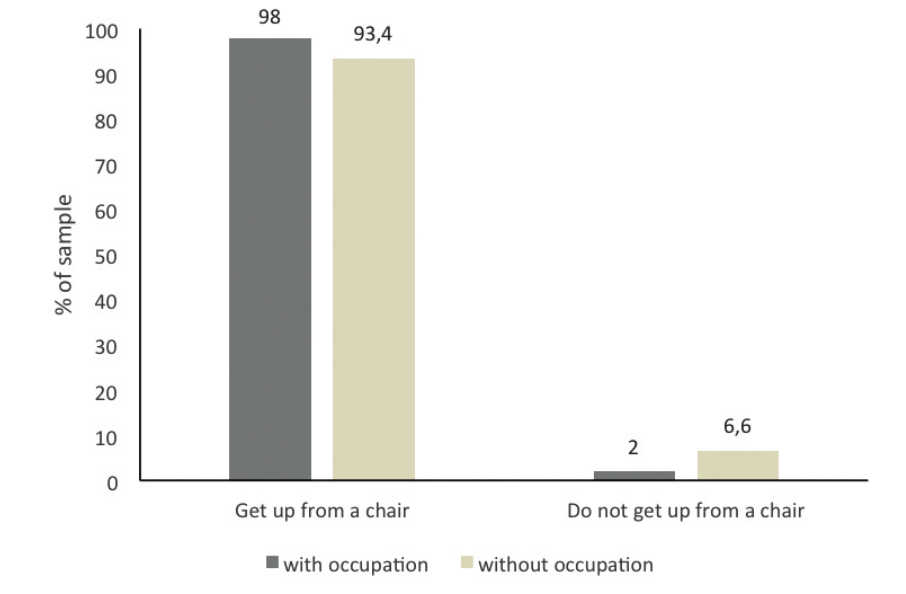
Figure 1 - Association between the functional ability of rising from a chair and having or not having an